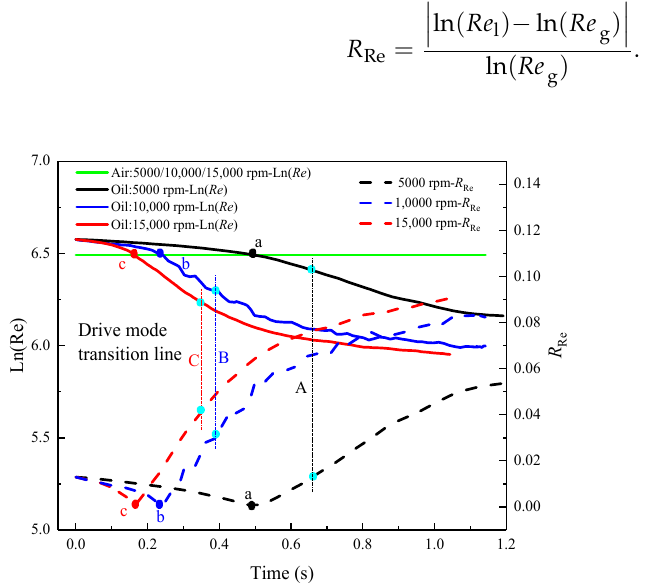
Figure 7. Variation in the natural log-Reynolds number of air and lubricating oil at different rotational speeds over time.